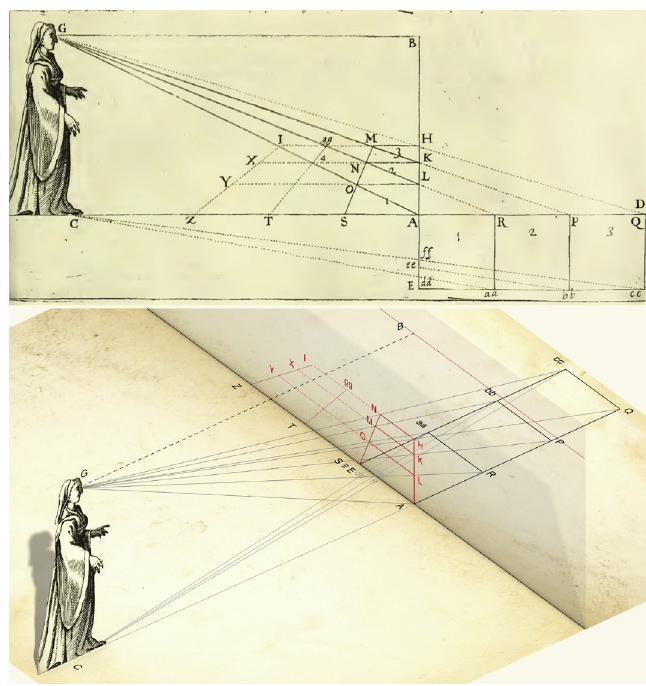
Figure 4 Illustration of the ‘first rule’ by Jacopo Barozzi da Vignola. Author’s